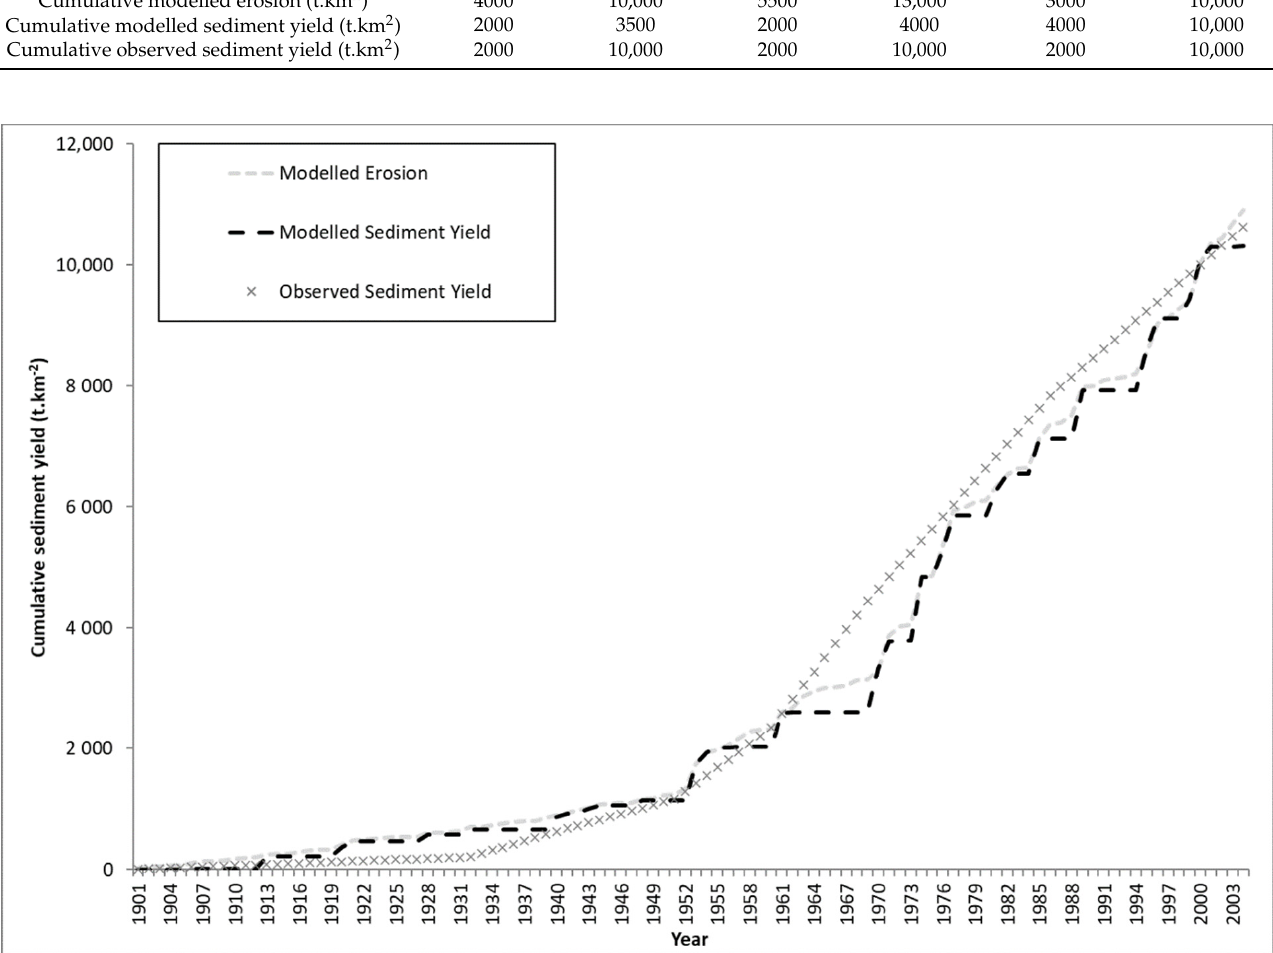
Figure 6. The cumulative modelled erosion and sediment yield versus cumulative observed sediment yield for the Cranemere catchment when incorporating a “switch” in connectivity.